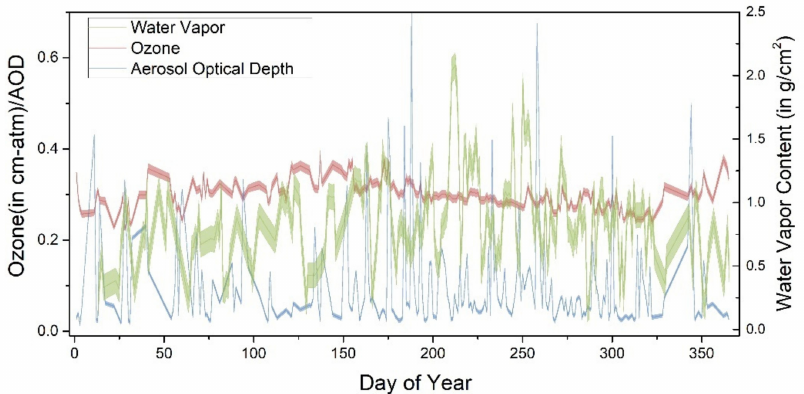
Figure 2. The temporal atmospheric conditions over Railroad Valley Playa site in 2019, including aerosol optical depth at 550 nm, water vapor and ozone